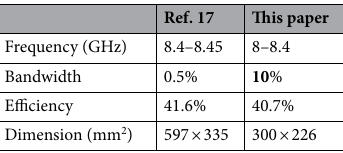
Table 2. Performance comparison between Ref. 17 and this